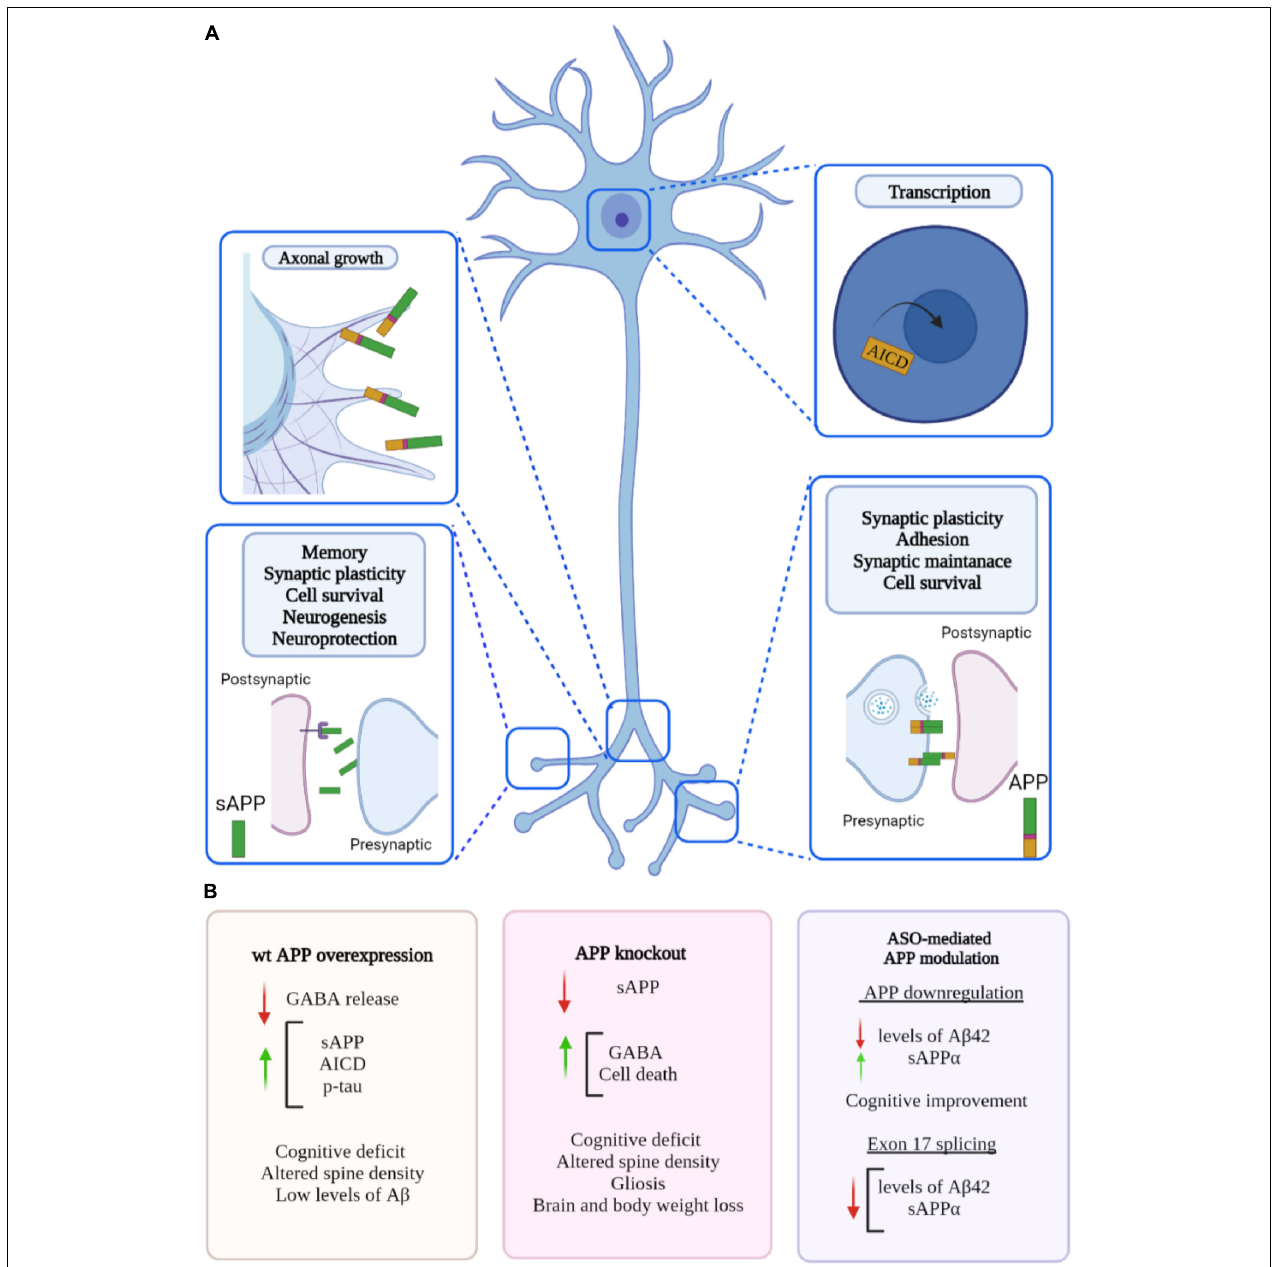
FIGURE 3 | Proposed roles of amyloid precursor protein (APP) and phenotypes associated to changes in APP level. (A) APP plays a role in many biological processes including maintenance of synapse, transcriptional regulation, plasticity, and neuroprotection. APP is cleaved into biologically active fragments; APP intracellular domain (AICD) translocates to the nucleus where it regulates transcription; APP localises to the neuronal growth cone where it regulates axon growth; APP dimerization occurs at the synapse (in trans and in cis ) between two molecules of APP regulating synaptic stability (similar dimerization occurs at the neuromuscular junction). (B) Phenotypes associated with overexpression of wild type APP, APP knockout and ASO-mediated APP modulation. Created with